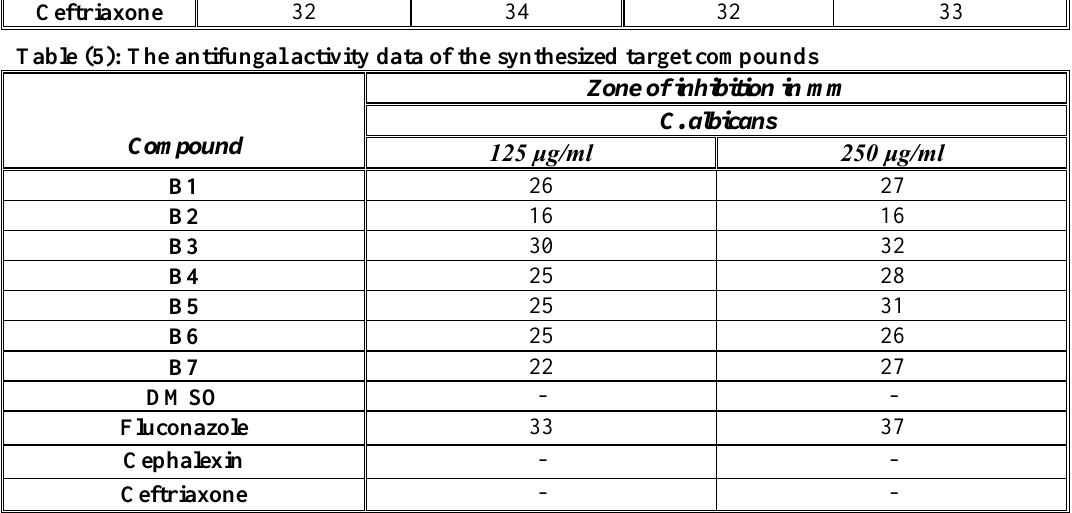
Table (5): The antifungal activity data of the synthesized target compounds